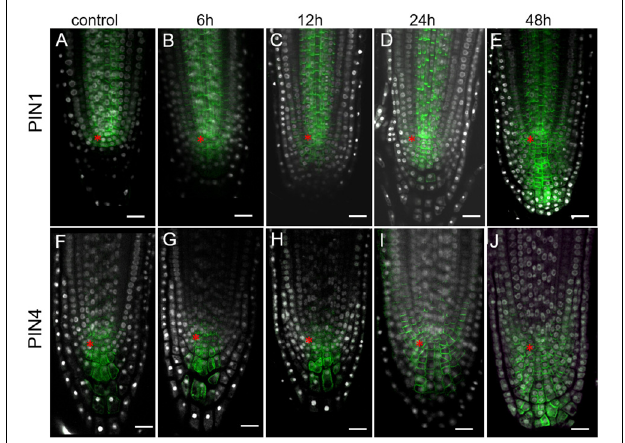
FIGURE 4 | Expansion of PIN1 and PIN4 expression domains in 35S:WOX5-GR root tips during DEX exposure. (A–J) Immunolocalization of PIN1 (A–E) and PIN4 (F–J) are in green at 0, 6, 12, 24, and 48 time points of DEX incubation. N = 10. DAPI is in white. The QC location is marked by the red asterisks. The bar scale – 20 µ